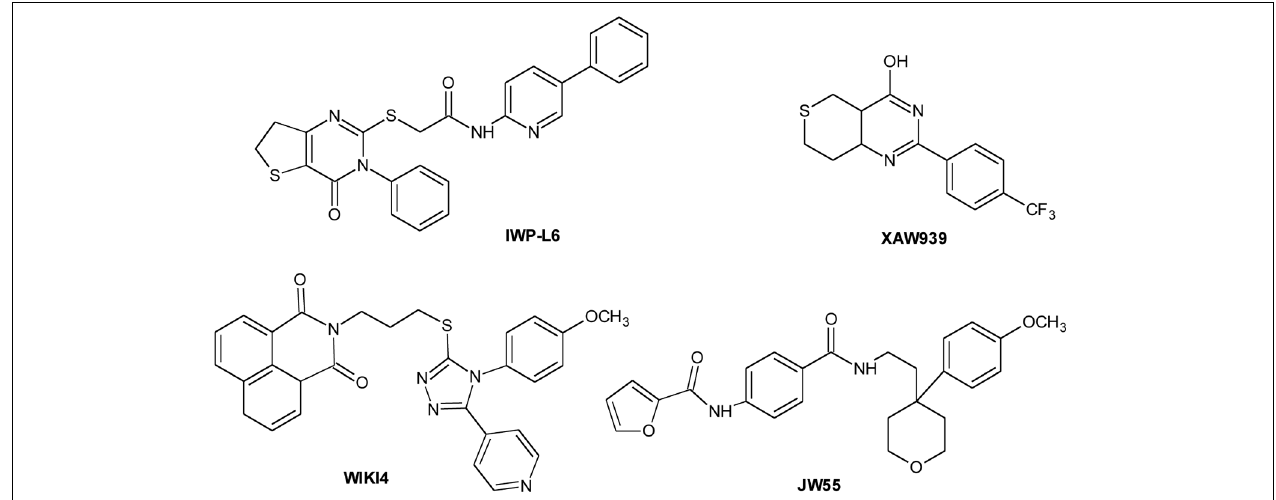
Chart 2 | Porcupine and Tankyrase